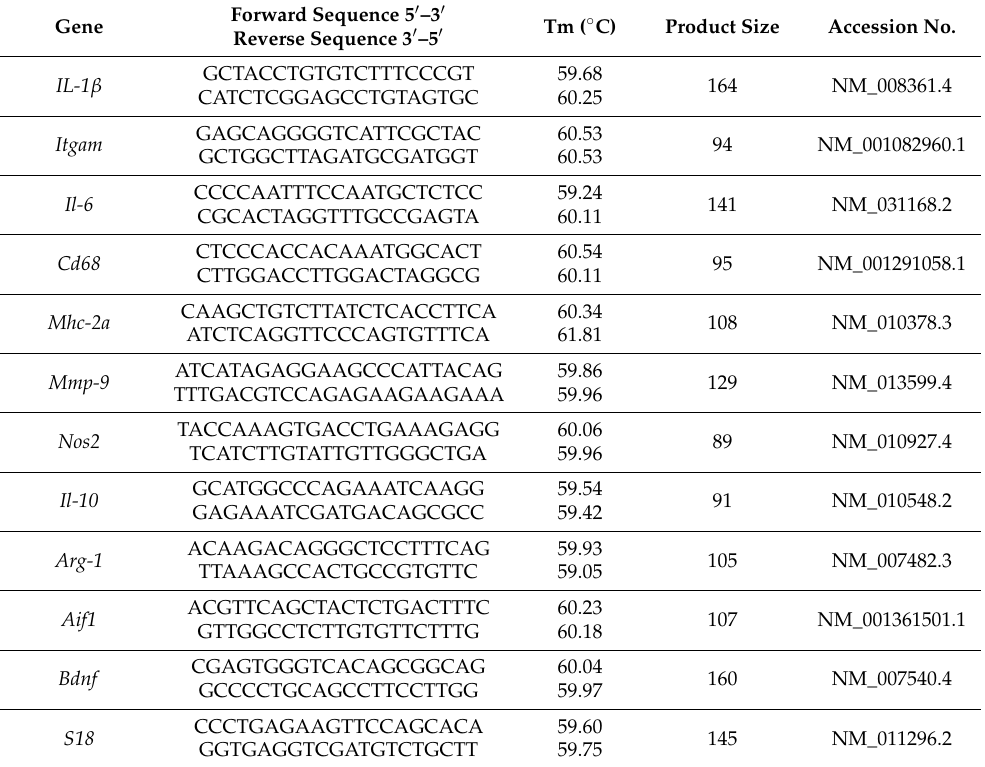
Table 1. Oligonucleotide primers sequences used to amplify the genes of interest. Sequences were optimised for use in real-time qPCR studies and SYBR green technology, with predicted amplicons < 165